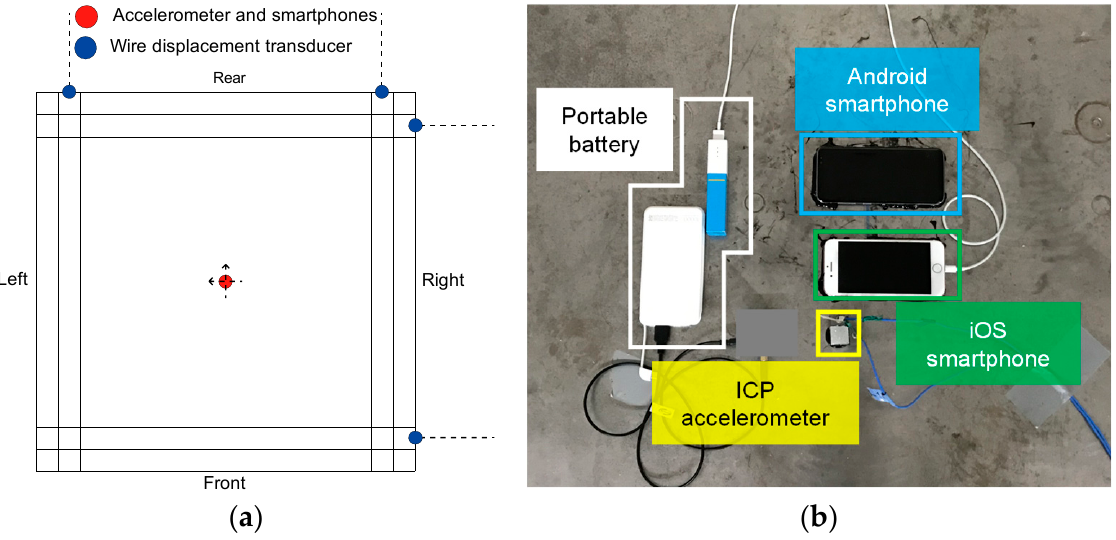
Figure 3. Installation of sensors: ( a ) sensor position; ( b ) smartphones.